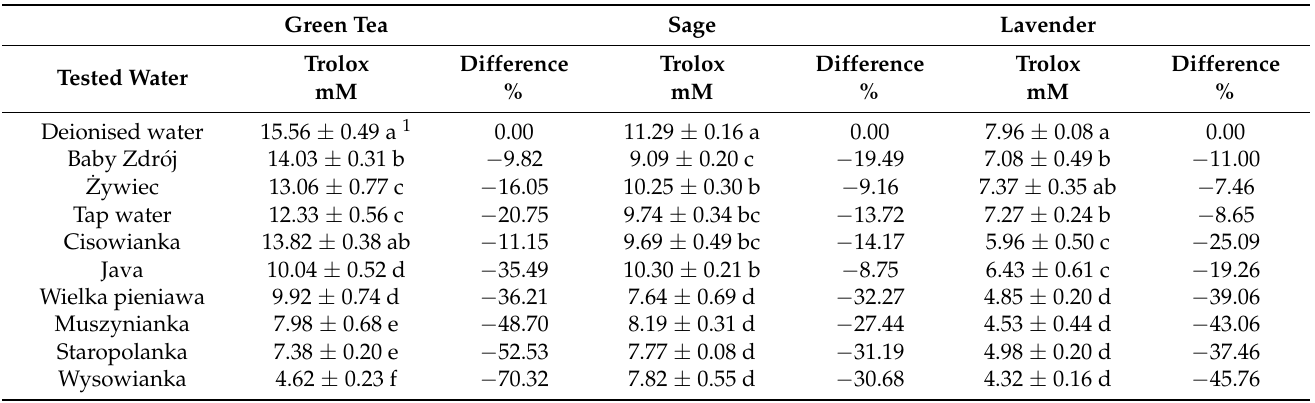
Table 3. Percentage decrease of antioxidant activity (converted to mM of Trolox) of green tea, sage and lavender brews prepared with the use of mineral waters relative to the brew prepared with the use of deionized water. Green Tea Sage